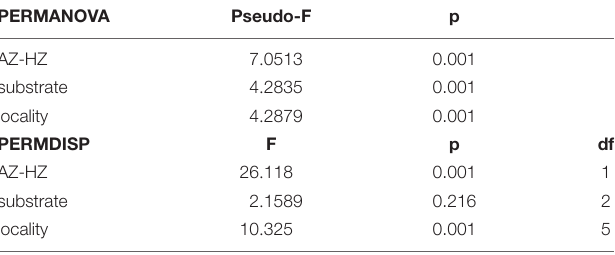
TABLE 3 | Results of PERMANOVA and PERMDISP analysis.